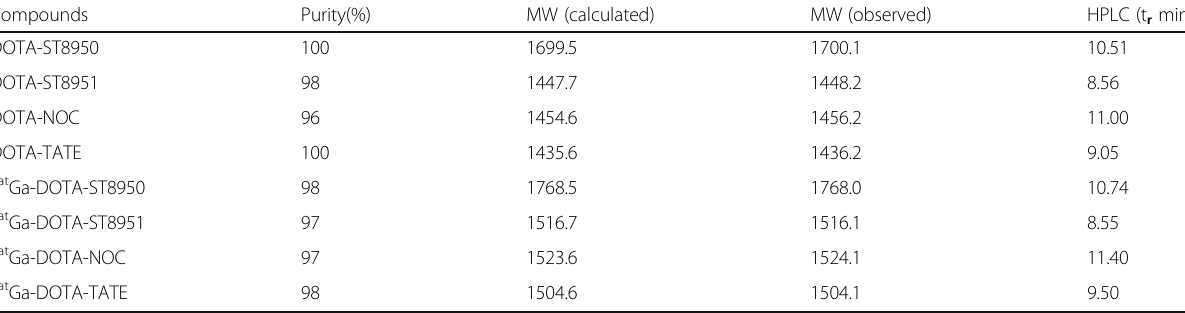
Table 1 Analytical data of the DOTA conjugates and of their corresponding nat Ga-complexes Compounds